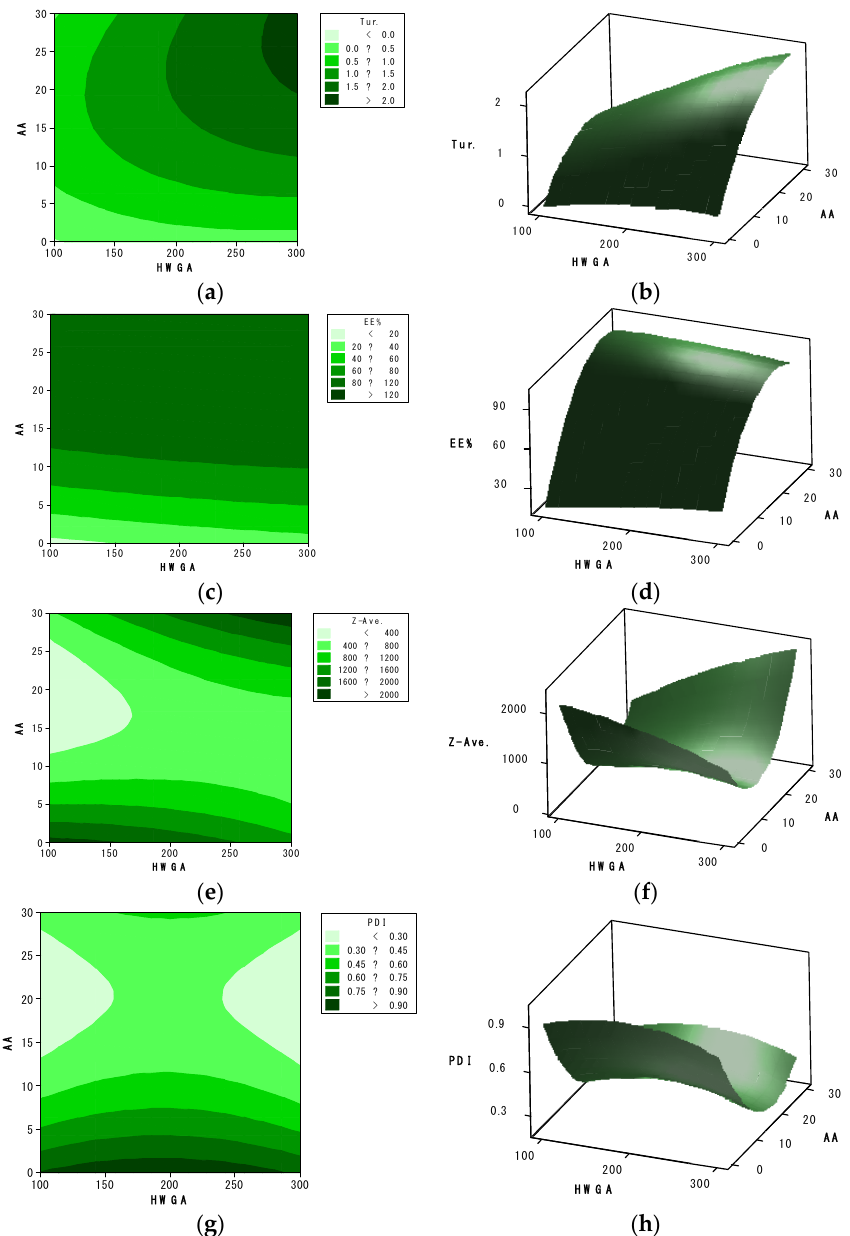
Figure 5. Contour plots ( a , c , e , g ) and response surface plots ( b , d , f , h ) of turbidity ( a , b ), encapsulation efficiency ( c , d ), particle size ( e , f ), and polydispersity index ( g , h ). HWGA and AA represent the volumes ( µ L) of the 1% HWGA (X 1 ) and 0.5 mM acetic acid solutions (X 3 ), respectively. SA (X 2 ) was fixed at 200 μ L.